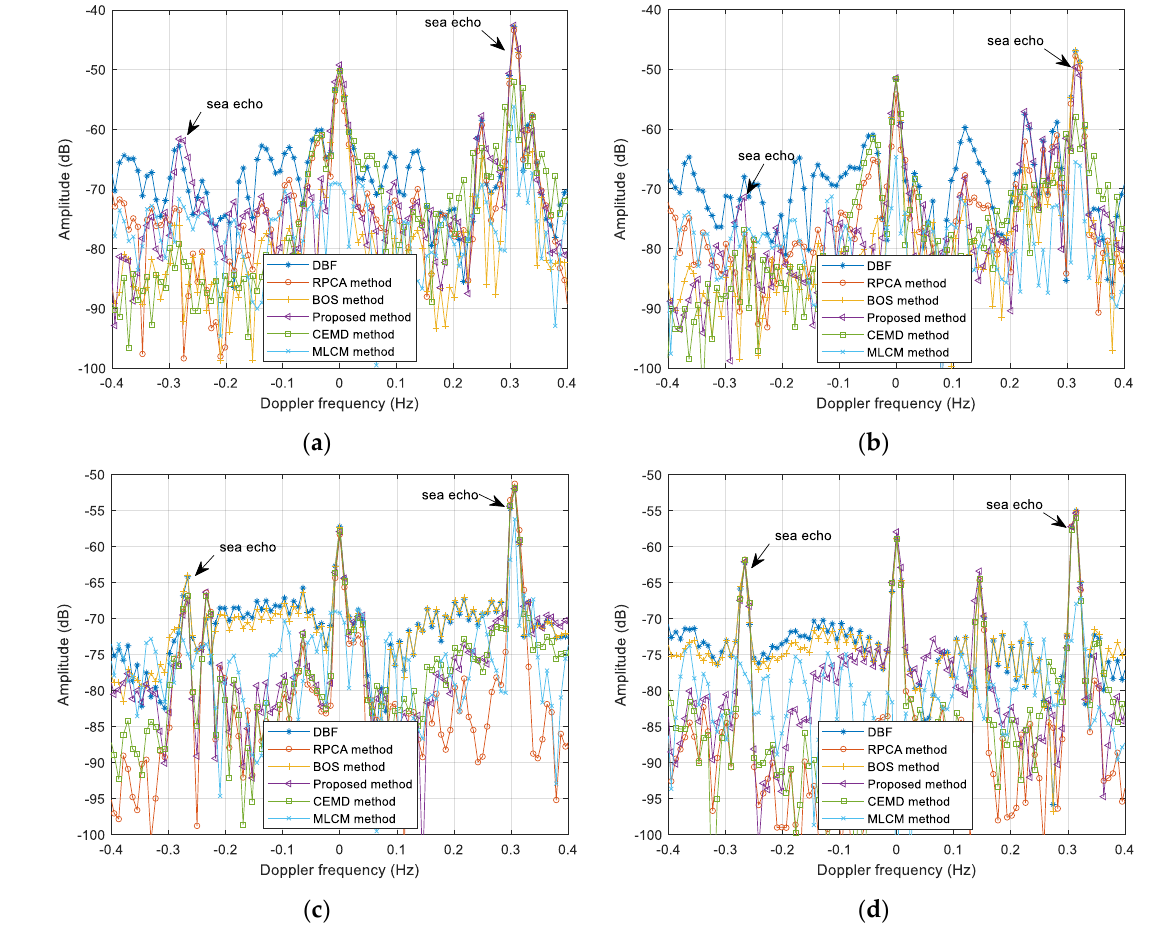
Figure 6. Comparison results of transient interferences mitigation in Doppler profiles: ( a ) LCI result at 2nd range unit; ( b ) LCI result at 12th range unit; ( c ) STI result at 2nd range unit; ( d ) STI result at 12th range unit.